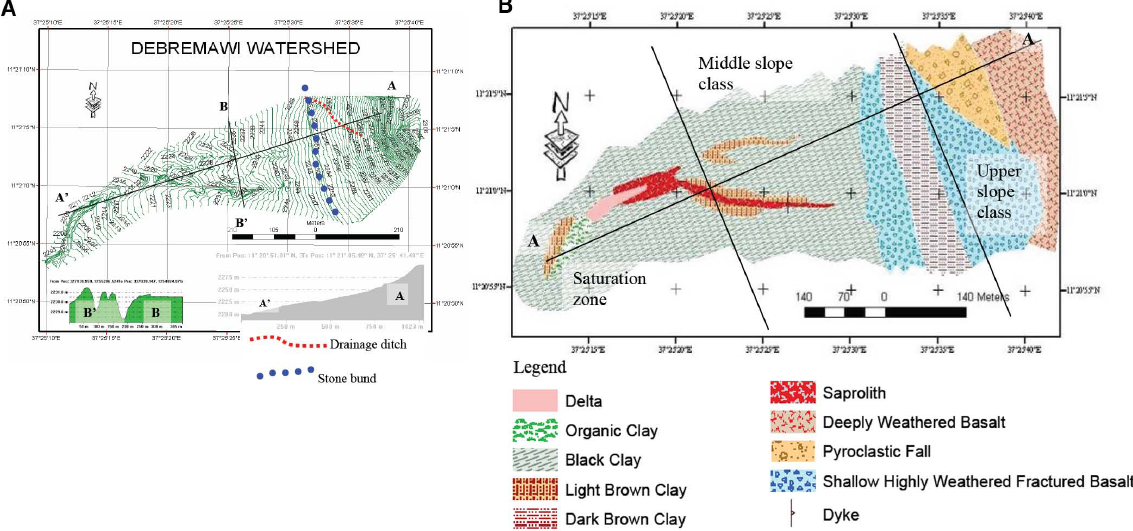
Fig. 2. (a) Contour map of the gully erosion site with gully profile transect and (b) soil map of the gully erosion